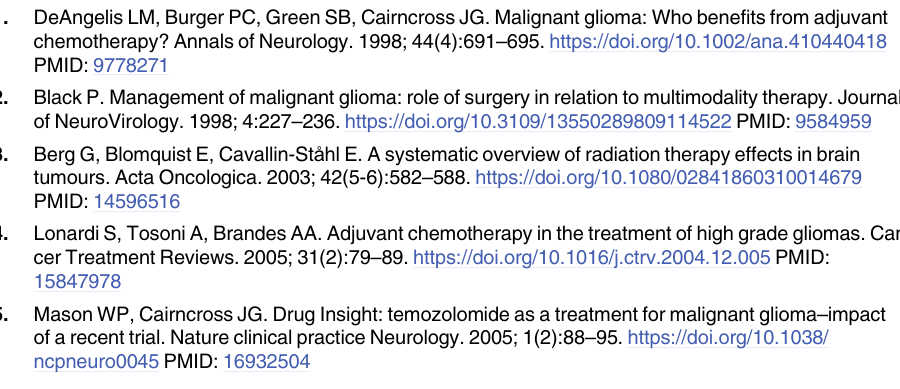
S8 Fig. Cell densities from two two-step fractions of logistic growth and exponential death. Cell densities resulting from the optimal radiation profiles from two 2-step fractions of logistic growth and exponential death of (from left to right) σ = 1, σ = 3, and σ = 5. The red dots are those below the detectable threshold in imaging, of 5 cells/mm 2 , and the blue dots those above. Note the different y-axis scales to highlight the resulting shape. S9 Fig. Cell densities from one two-step fractions of logistic growth and death. Cell densi- ties resulting from the optimal radiation profiles from one 2-step fraction of logistic growth and death of (from left to right) σ = 1, σ = 3, and σ = 5. The red dots are those below the detect- able threshold in imaging, of 5 cells/mm 2 , and the blue dots those above. Note the different y- axis scales to highlight the resulting